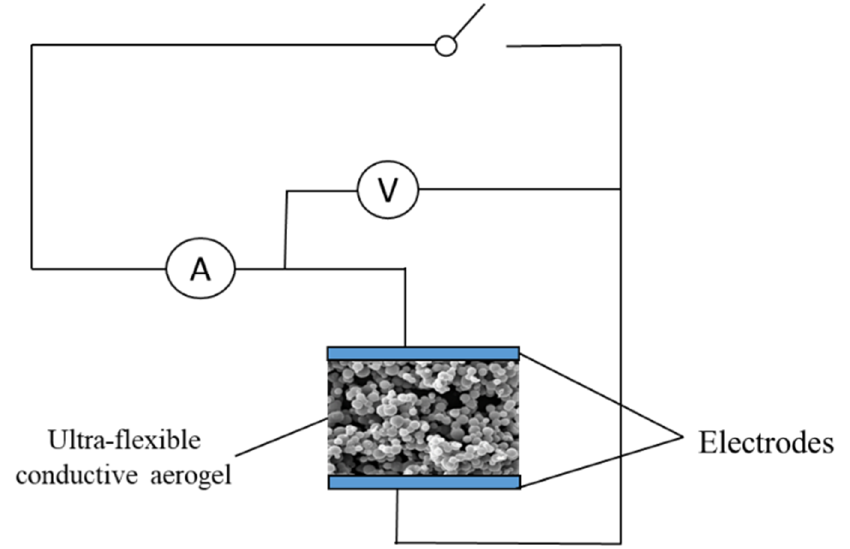
Figure 10. Schematic diagram of a multiparameter sensor setup.